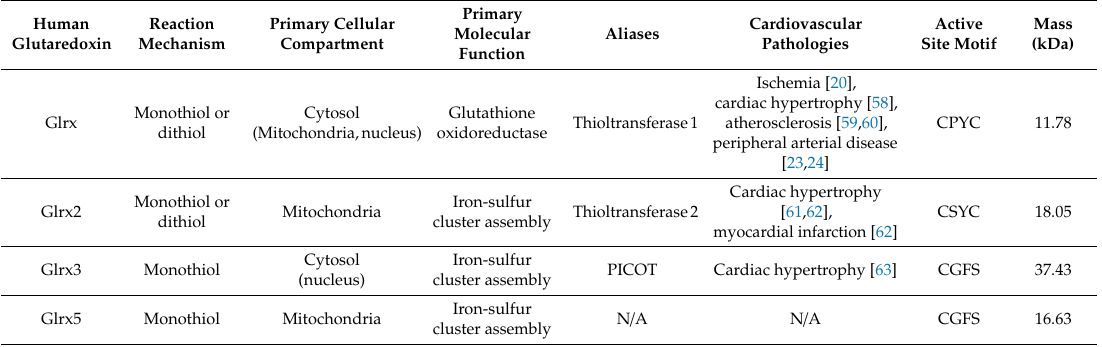
Table 1. Characteristics of human glutaredoxins. Glrx, glutaredoxin-1; Glrx2, glutaredoxin-2; Glrx3, glutaredoxin-3; Glrx5, glutaredoxin-5; C, cysteines; P, proline; F, phenylalanine; Y, tyrosine; S, serine; Da, daltons; PICOT, PKC-interacting cousin of thioredoxin.